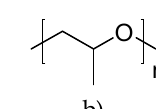
Figure 12. Shrink–swell behavior of a thermo-responsive hydrogel upon exposure to temperature. During the hydrogel shrinkage, the loaded drug is irreversibly released from the polymeric system. Adapted from [90].